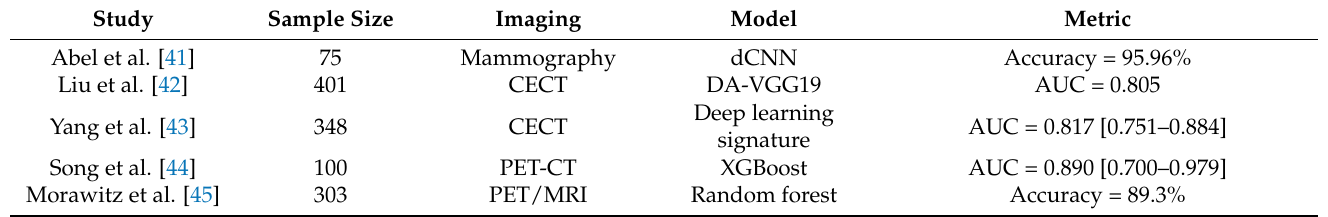
Table 3. Summary of studies using other imaging modalities for breast cancer lymph node